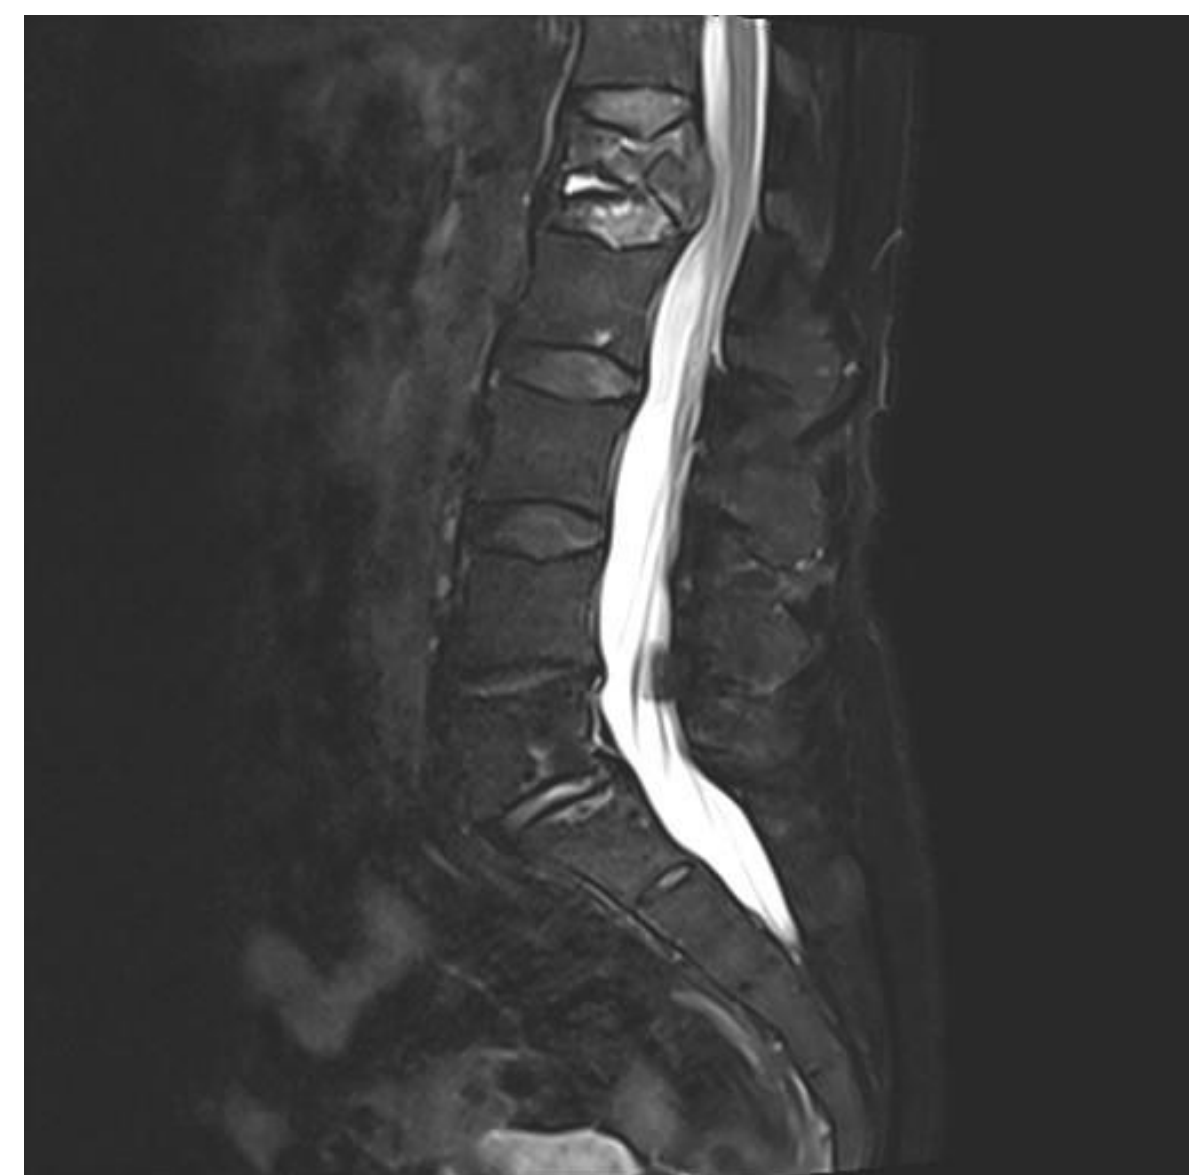
Figure 1. Magnetic resonance imaging (MRI) of lumbar column. The figure demonstrating collapse and fracture of vertebra corpus L1, with edema and compression against the spinal cord.